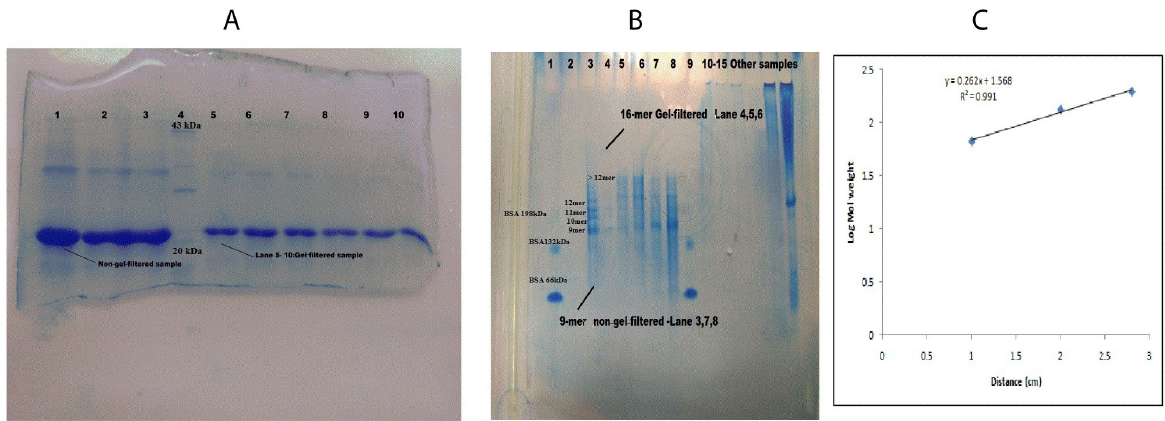
Figure 1. Acr purification and Native-PAGE gel analysis. (Figure 1 changed as recommended by Reviewer 2). ( a ) SDS-PAGE of gel filtration runs 1 and 2. Lanes 1, 2, 3: Load -1X and 2X β -mercaptoethanol ( β -ME); lane 4: marker showing 14, 20, 22, 25, 35, 43, 50, 56, 66 and 80 kDa; lanes 5-7: run 1 C1 1X, 2X and 3X β -ME; lanes 8-10: run 2 C2 1x, 3x and 2x β -ME. ( b ) Native-PAGE of His-tag-eluted non-gel-filtered samples and gel-filtered elute. Lane 1, 9: BSA control; lane 3: non-gel filtered; lanes 4, 5, 6: gel-filtered; lane 7, 8: non-gel-filtered. ( c ) Plot of log molecular weight of the different forms of BSA in Native-PAGE. The different sizes of BSA 66, 132 and 198 kDa were plotted against distance migrated and the log molecular weight was plotted in MS excel and the equation displayed and used to calculate oligomer size of non-gel-filtered and gel-filtered samples.